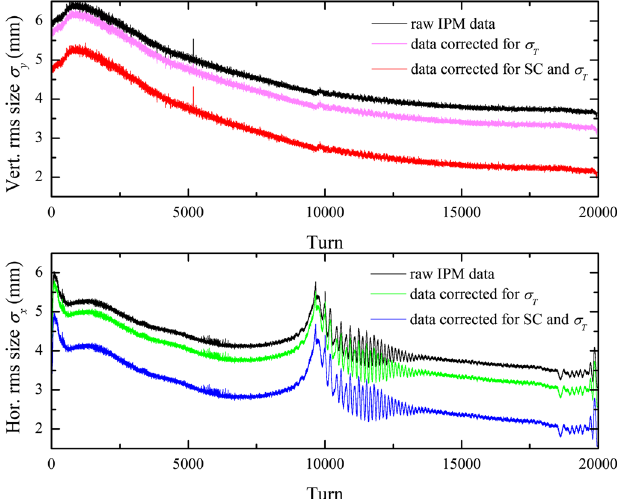
FIG. 10. An example of reconstruction of vertical (top plot) and horizontal (bottom plot) rms proton beam sizes in the 33 ms (20 000 turns) acceleration cycle of the Fermilab 8 GeV Booster synchrotron with the total beam intensity of N p ¼ 4 . 6 × 10 12 : time dependence of the original IPM data σ 2 m; corrected for smearing effects σ (cid:4) and the same data after addi- tional correction for the space-charge expansion σ 0 with param- eters D ¼ 103 mm, d ¼ 52 mm, V ¼ 24 kV — see text and Eqs. (4) and (5).